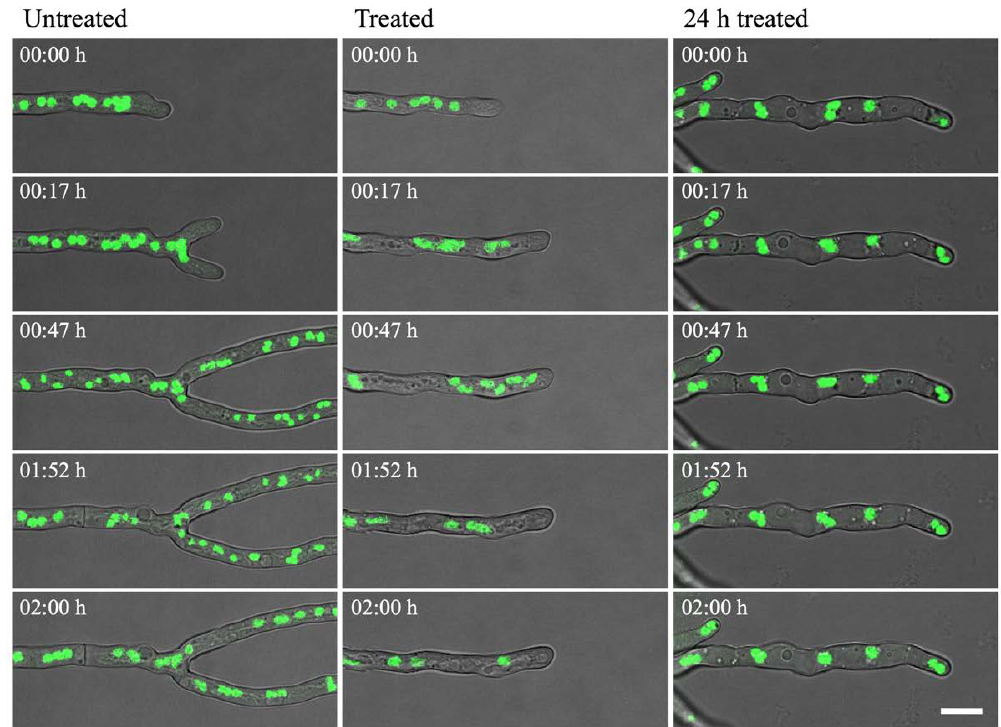
Figure 6. H1-GFP hyphae were incubated either in the absence (untreated) or presence (treated; 24 h treated) of 0.1 µg/mL olorofim. The nuclei (green) were observed from 0–2 h (untreated; treated) or from 24–26 h (24 h treated). In untreated hyphae, nuclei moved at a steady rate, which increased 15–20 min after addition of olorofim. In hyphae treated for 24 h, nuclear motility was almost static. Scale bar = 10 µm.